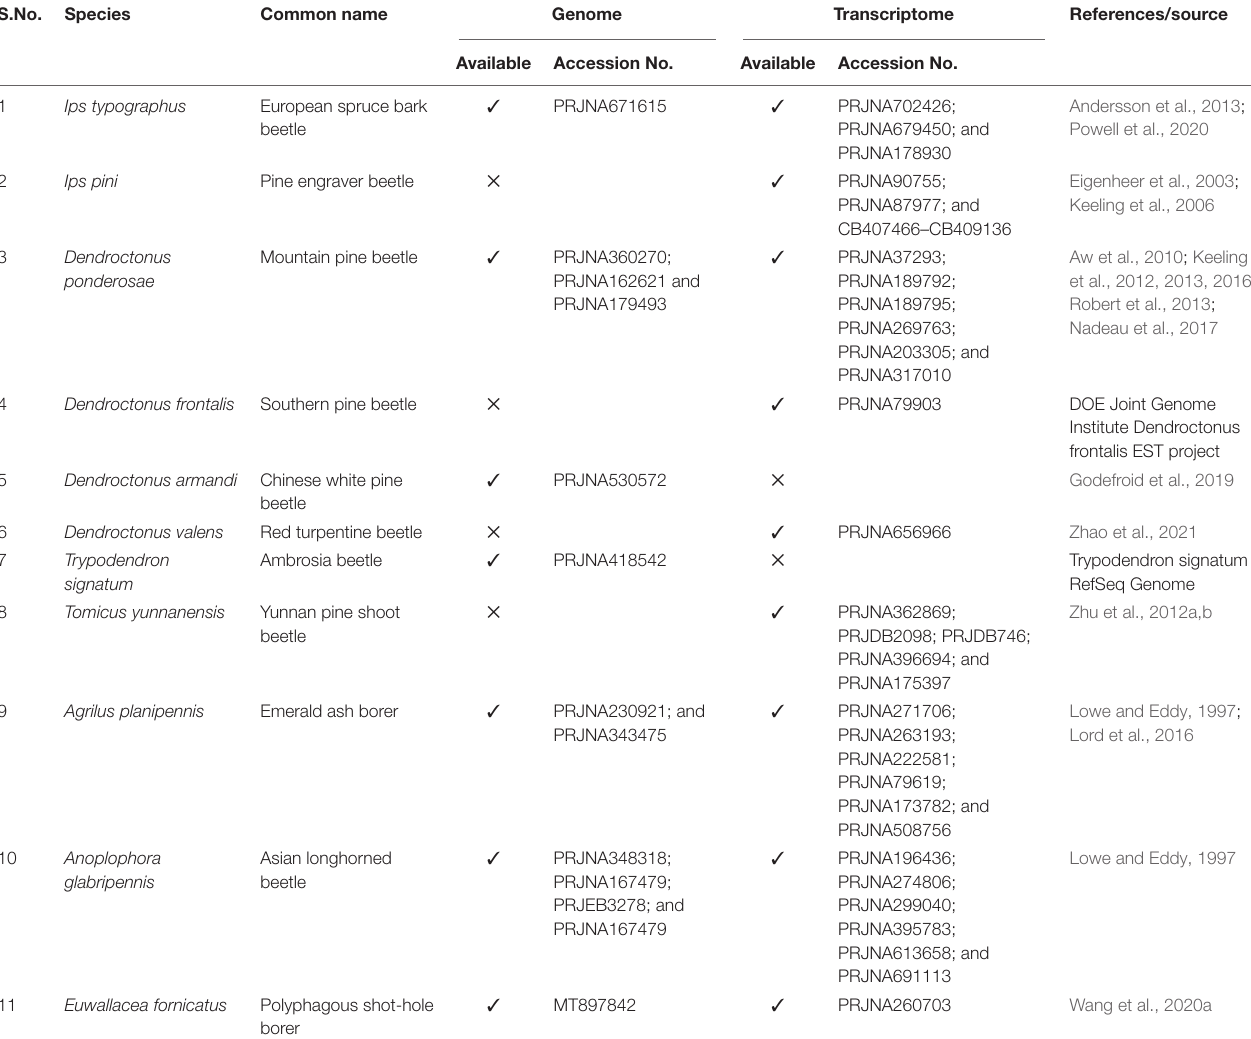
TABLE 3 | List of genome and transcriptomics studies done with wood-boring